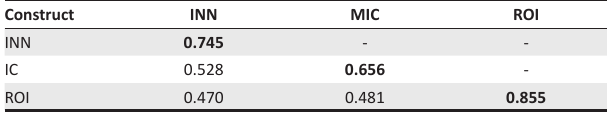
TABLE 4: Correlation matrix to assess discriminant validity.